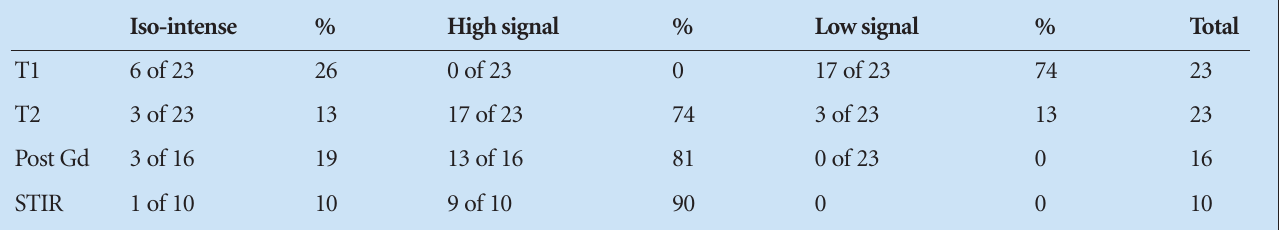
Table III. Signal intensities in partially affected vertebrae